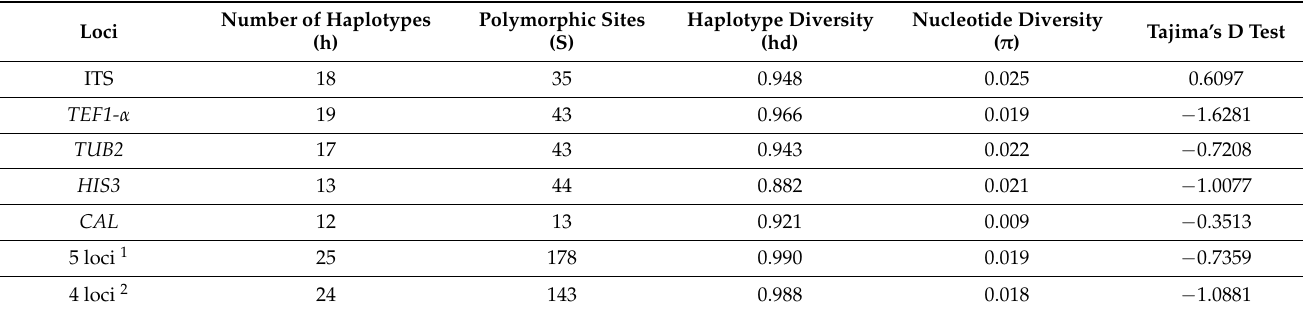
Table 3. Polymorphism and genetic diversity data for the Diaporthe eres species complex.